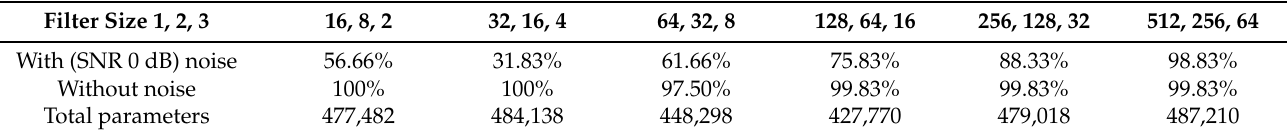
Table 6. The effect of filter size on the performance of the proposed model in noisy conditions.